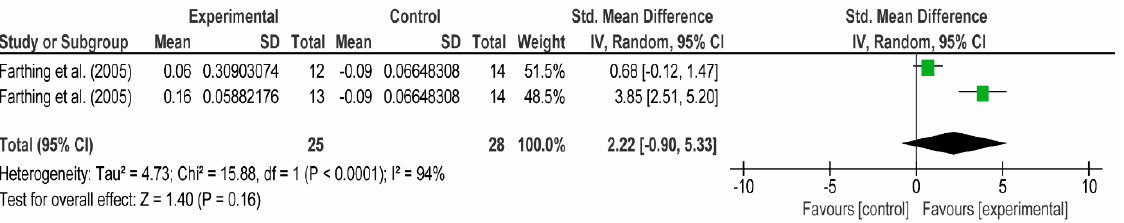
Figure 24. The effect size of 6-weeks of isometric ulnar deviation training [78] on flexor carpi ulnaris